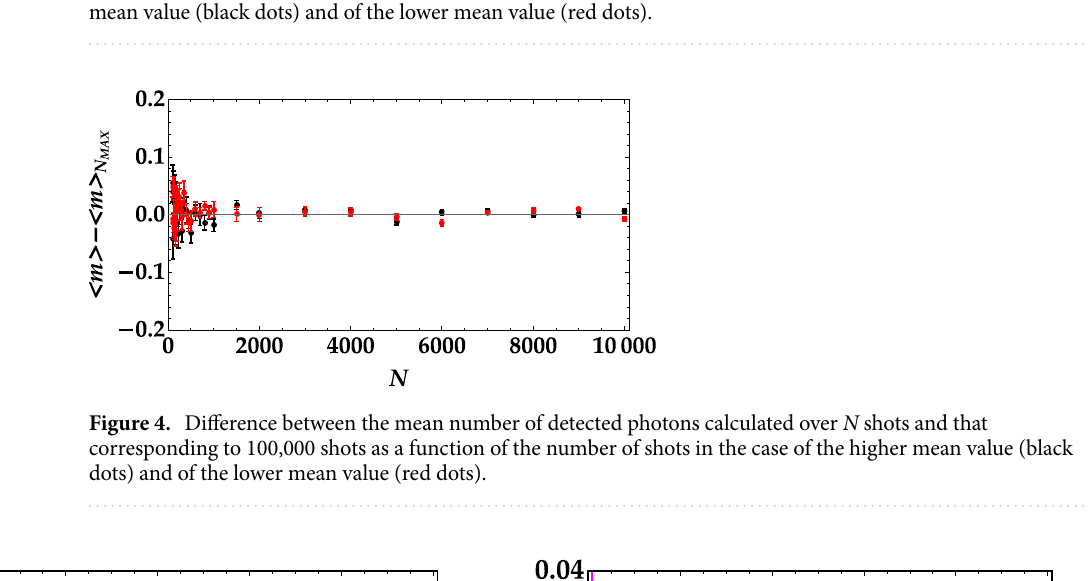
Figure 3. Mean number of detected photons as a function of the number of shots in the case of the higher mean value (black dots) and of the lower mean value (red dots).